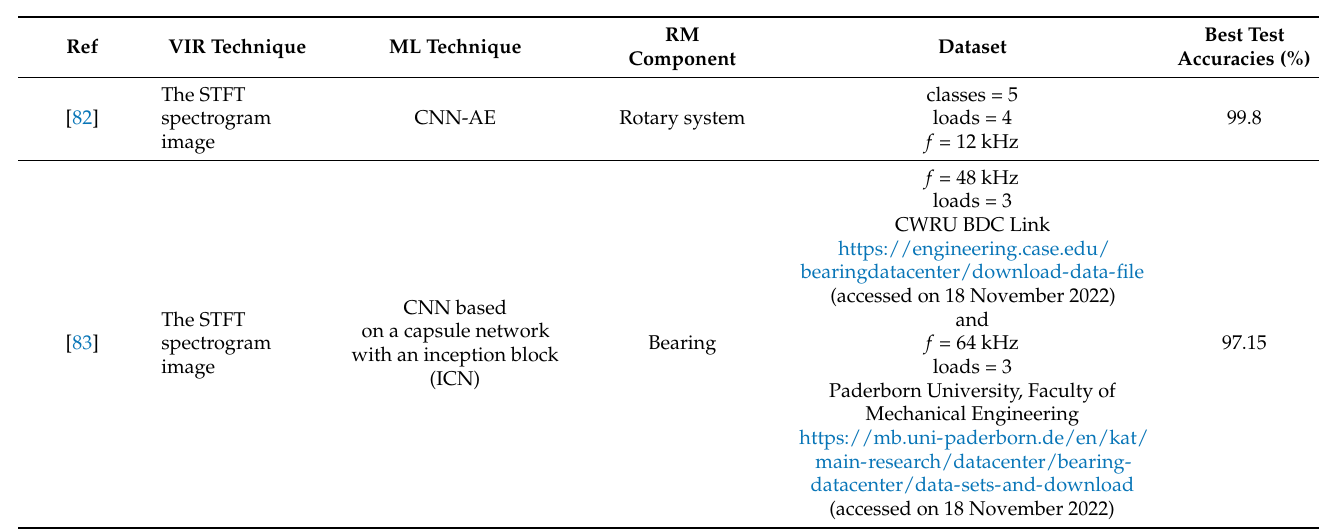
Table 3. Summary of the time-frequency domain vibration image representation techniques that are used in different studies of machine fault